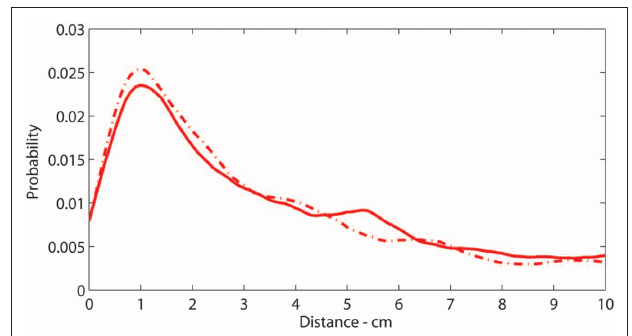
Figure 6 | Distributions of intervals of successive sustained waves: Distribution of estimated distance that unobservable sustained waves travel. Solid: